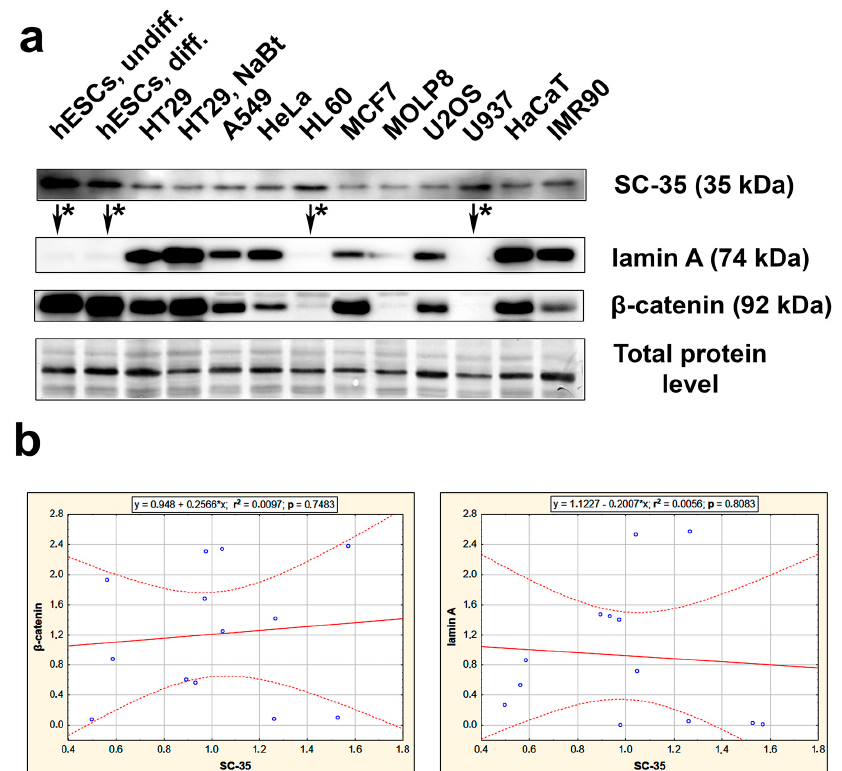
Figure 5. Studies on SC-35, lamin A, and β -catenin in distinct cell types. ( a ) The level of selected proteins was studied in the following cells: human ES cells (hESCs), partially differentiated hESCs, tumor cell lines, including HT29, A549, HeLa, HL60, MCF7, MOLP8, U2OS, U937, and human keratinocytes HaCaT, and fibroblasts IMR90. Data on protein levels were normalized to the total protein levels. ( b ) Regression analysis, evaluating the correlation between SC-35 and lamin A ( p = 0.8083; r 2 = 0.0056), or SC-35 and β -catenin ( p = 0.7483; r 2 = 0.0097), is shown.